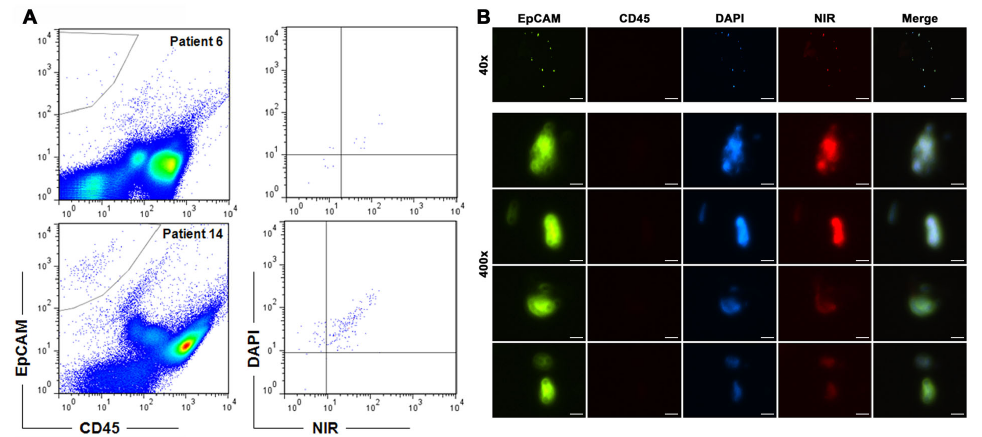
Figure 2. Application of the detection protocol to clinical samples from PCa patients. Representative detection results are shown. A , upper row shows CTC detection from patient 6, where 10 live CTCs were found. Lower row shows the detection of 148 live CTCs from patient 14. For each sample, gate setting was directed by parallel staining of PC-3 cells. B , CTCs detected from patient 14 were isolated onto a microscope slide and visualized immediately by fluorescence imaging. Low magnification images of a representative field (40 6 ; bar=250 m m) are shown in the upper row. Below, high magnification images of 2 live CTCs (NIR + ) from the same field are shown in the next two rows, in comparison to 2 dead CTCs (NIR 2 ) in the last two rows (400 6 ; bar=25 m m).